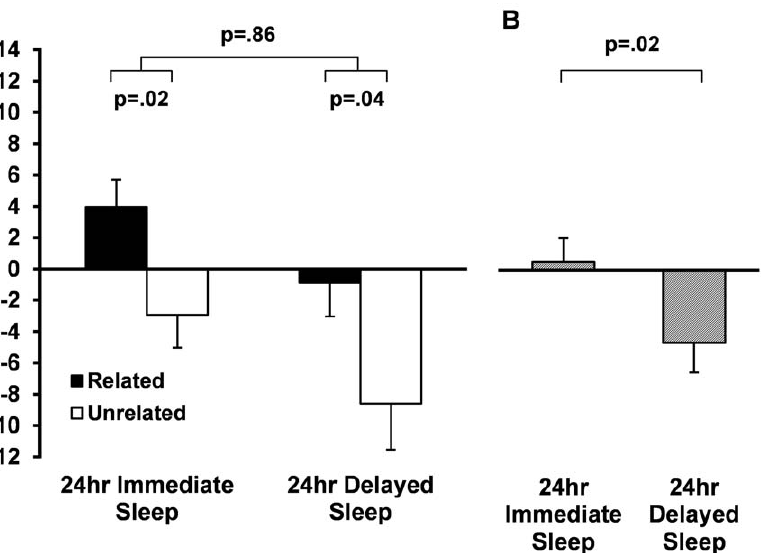
Figure 3. 24 hr Performance Data. A. Change in recall from training to retest for Related (black bars) and Unrelated (white bars) word pairs in the 24 hr Immediate Sleep and Delayed Sleep groups. B. Data collapsed across word pair type (striped bars). Bars represent % recall at training minus % recall at retest (means 6 SEMs). doi:10.1371/journal.pone.0033079.g003 PLoS ONE |